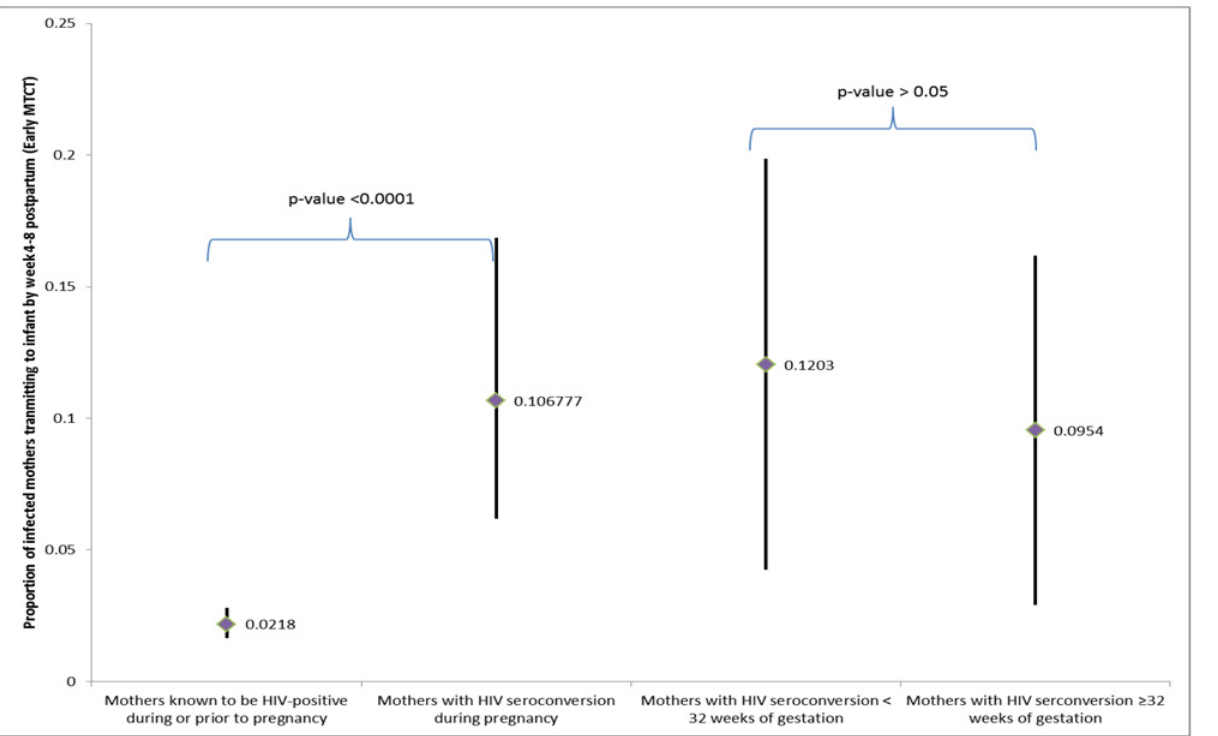
Fig 4. Weighted risk of early mother to child transmission among mothers with HIV seroconversions during pregnancy compared to mothers with reported HIV-positive status prior to the current pregnancy. This figure illustrates the estimate (diamonds) and 95% confidence intervals (vertical lines) for the proportion of HIV-infected mothers who had transmitted HIV to their infants by 4 – 8 weeks postpartum. Proportions are adjusted for the survey sampling design including clustering, design effects and nonresponse, and weighted to the population distribution of live-births for South Africa (SA) in 2011. The left panel of the graph shows a significantly higher proportion of mothers who seroconverted during pregnancy transmitted HIV to their infants than did mothers whose HIV infection was known to them before or during this pregnancy. The right panel subsets the women who seroconverted during pregnancy by the estimated week of gestation in which they seroconverted. Estimates of time of seroconversion were imputed using a uniform distribution to assign an equal probability of seroconversion to each day between delivery and the last reported negative HIV test during pregnancy. The graph shows results based on combined analysis of 20 imputations of this variable, and shows that the confidence intervals for the estimated proportion of mothers transmitting to their infants did not differ whether the mother was estimated to have seroconverted before or after 32 weeks gestation.